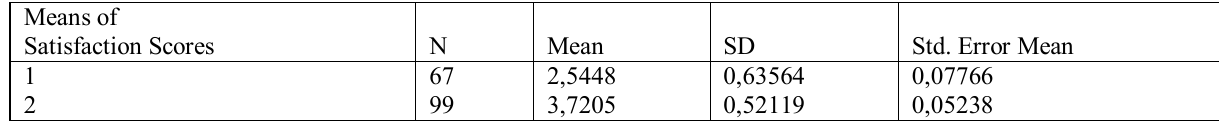
Table 3. Classifying Satisfying